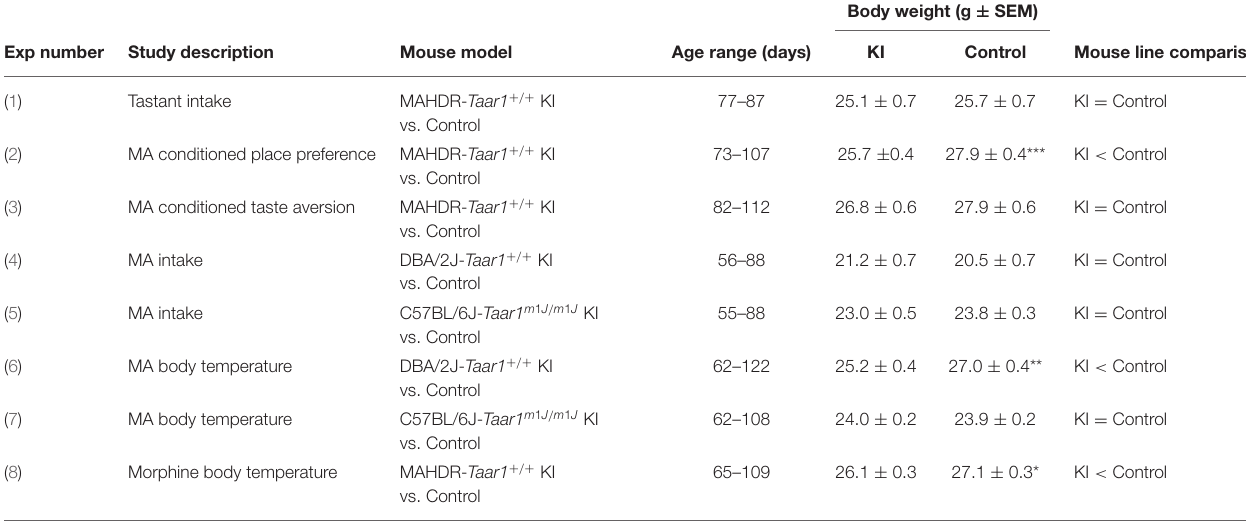
TABLE 1 | Body weight and age range data for each